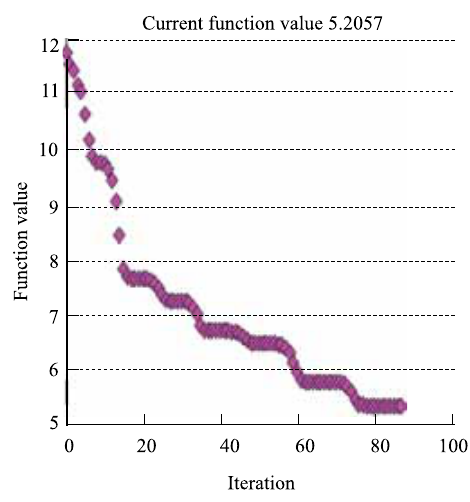
Fig. 8. Mean values and standard deviations of the estimated stiffness